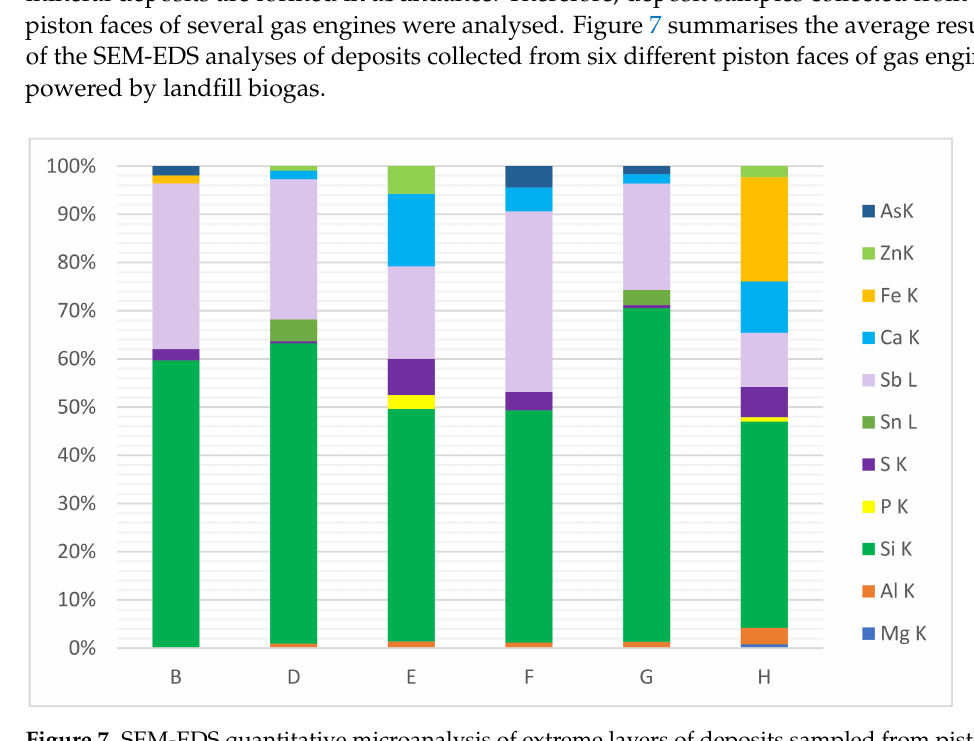
Figure 7. SEM-EDS quantitative microanalysis of extreme layers of deposits sampled from pistons (landfills B,D–H), mass fraction